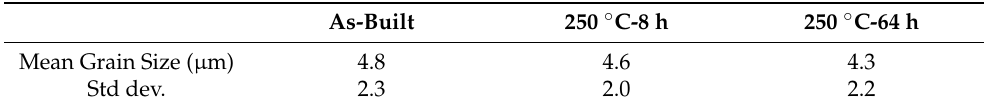
Figure 5. EBSD orientation maps on XY section of ( a ) as-built and annealed samples for ( b ) 8 h and ( c ) 64 h; in the inset, the orientation colour code for cubic crystal. Table 3. Average grain size obtained from EBSD data for as-built and 250°C-heat treated samples for 8 and 64 h.